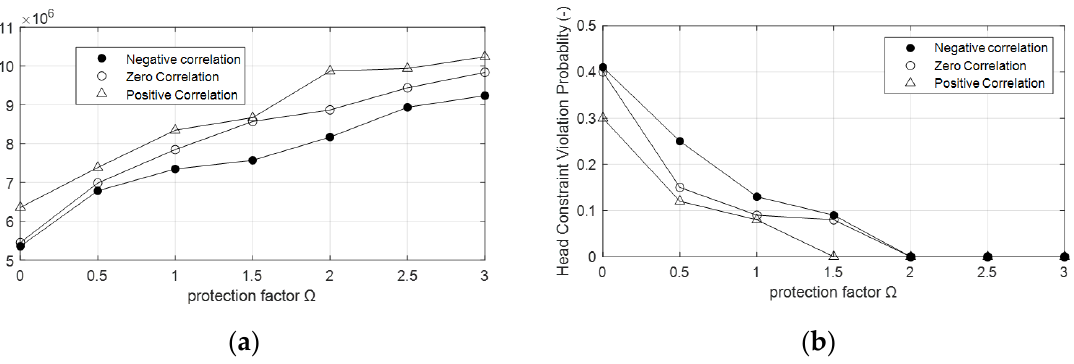
Figure 10. Results of correlated optimization for Fossolo network: ( a ) cost vs. protection factor Ω ; ( b ) head constraint violation probability.